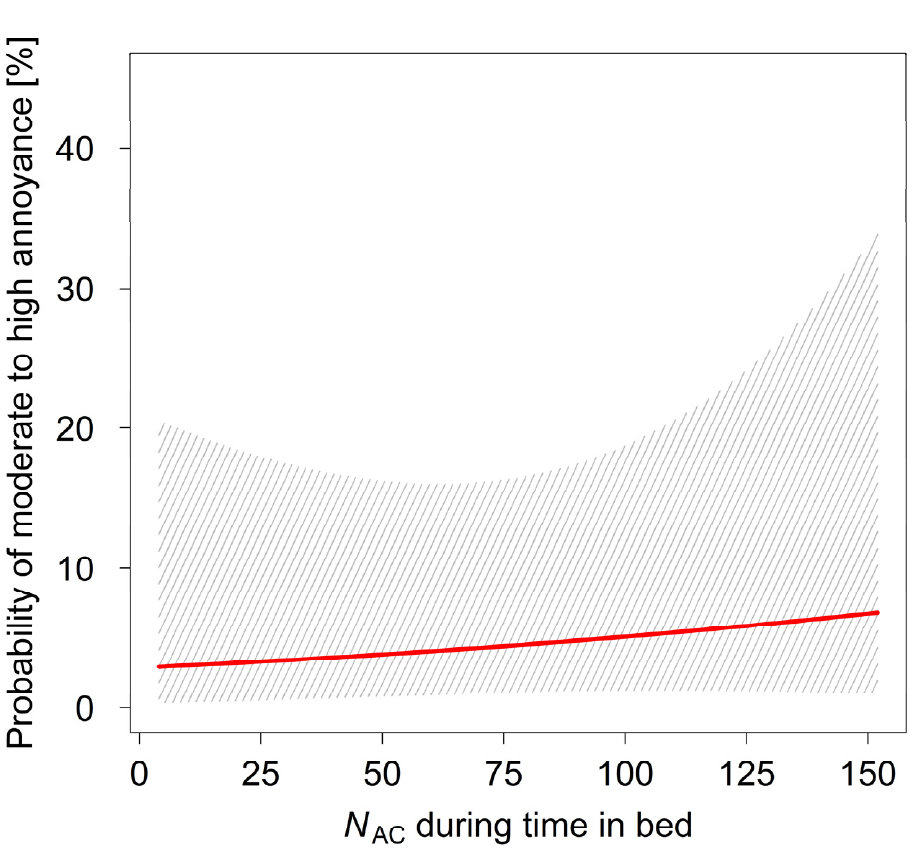
Figure 3. Probability for annoyance (categories ≥ 3) by aircraft noise of the previous night as predicted by model LR3 depending on the number of aircraft ( N AC ) during time in bed. The hatched area shows the 95% CI.